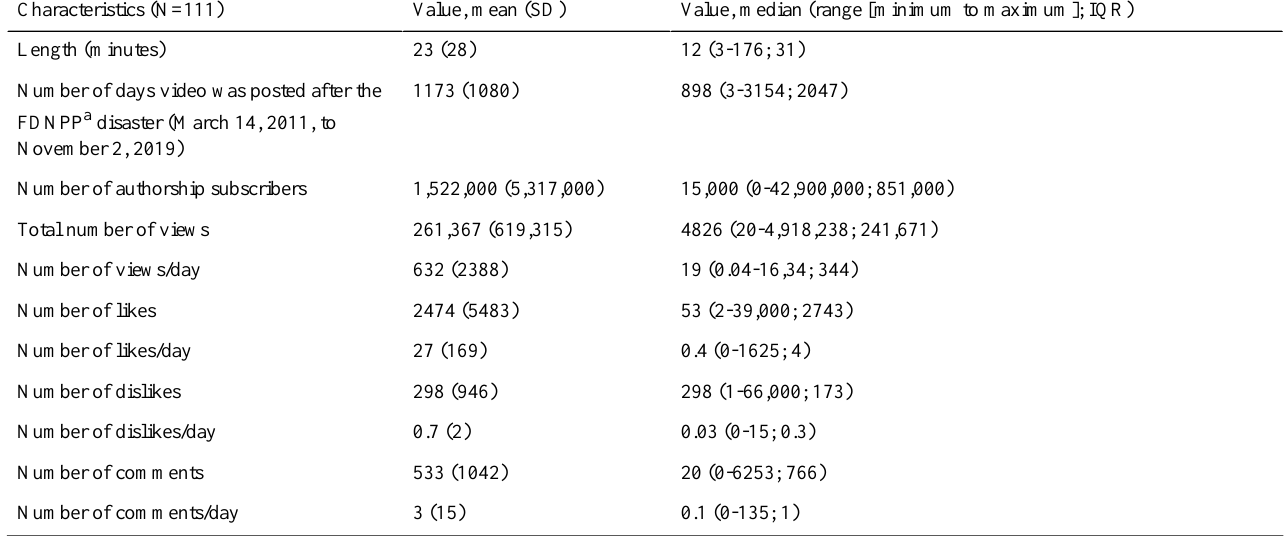
Table 1. Descriptive characteristics of